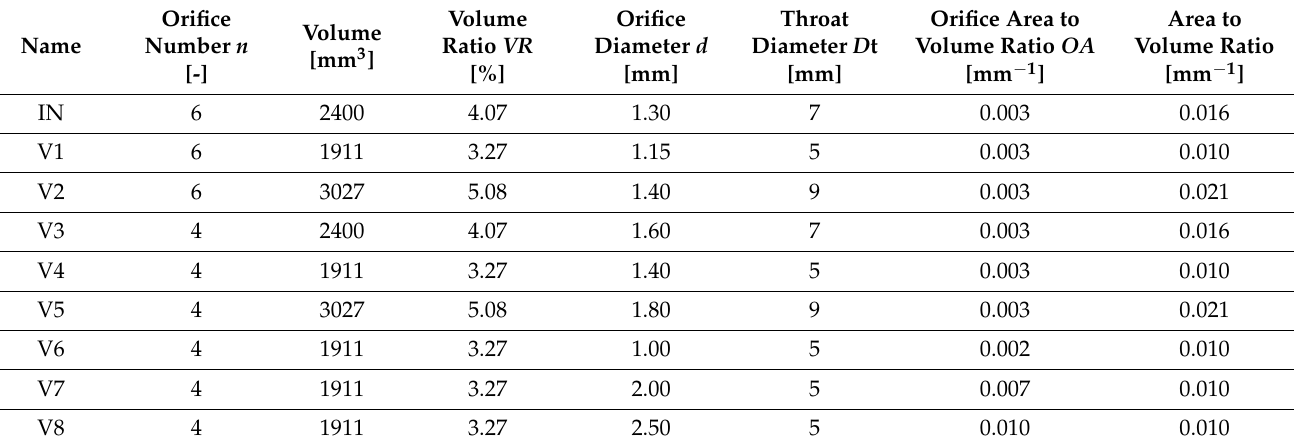
Table 1. Parameters of pre-chamber variants used in the